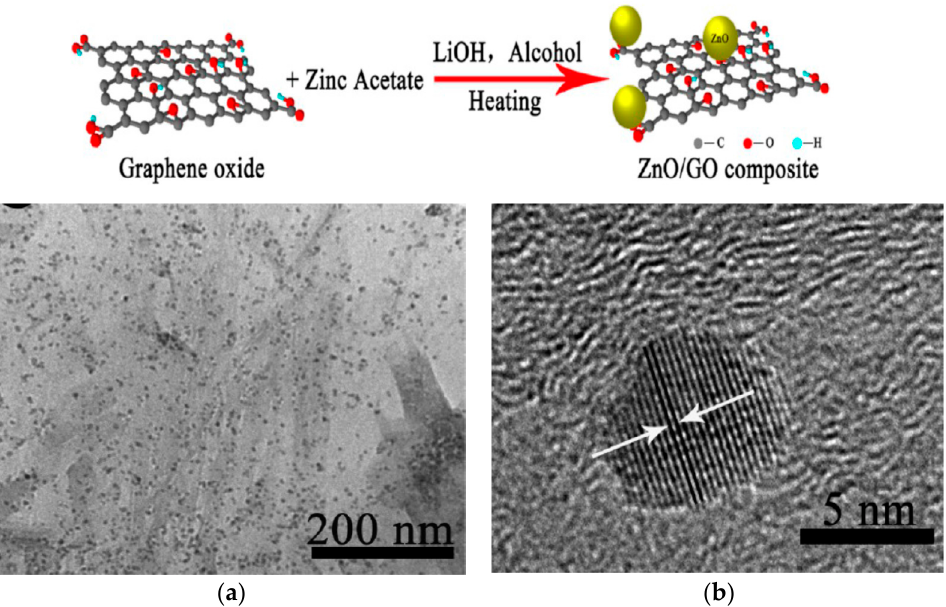
Figure 21. Formation of GO-ZnO nanocomposites using solvothermal process. ( a ) Transmission electron micrograph showing dispersion of ZnO nanoparticles on graphene sheet. ( b ) HRTEM image showing the lattice fringes of ZnO nanoparticle. Reproduced from [242] with permission of the American Chemical Society.